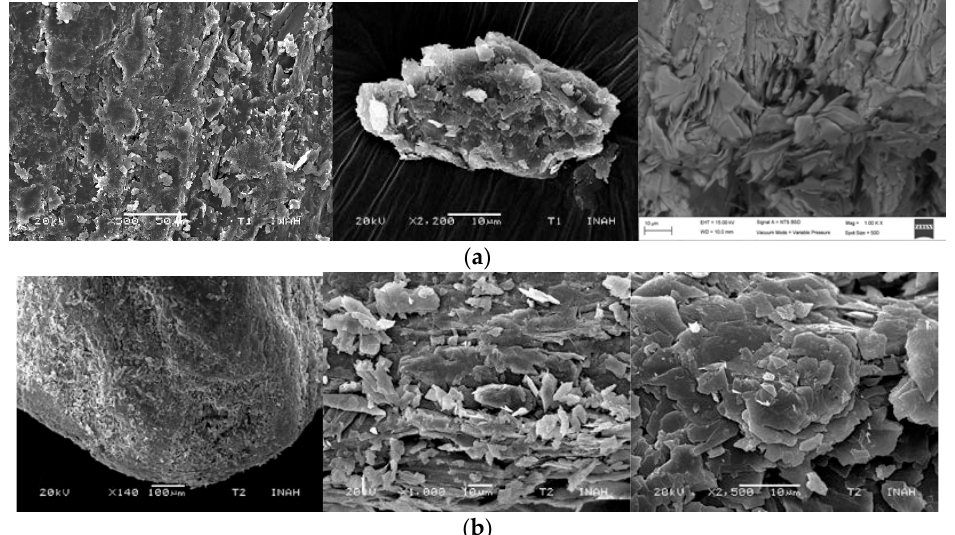
Figure 6. Dimensions and morphology of crystals and aggregates of Mexican talcs observed by SEM. ( a ) Oaxaca talc with intermediate platy morphology related with a morphological index of 0.6; ( b ) Puebla talc with predominant platy morphology related with a morphological index of 0.8.